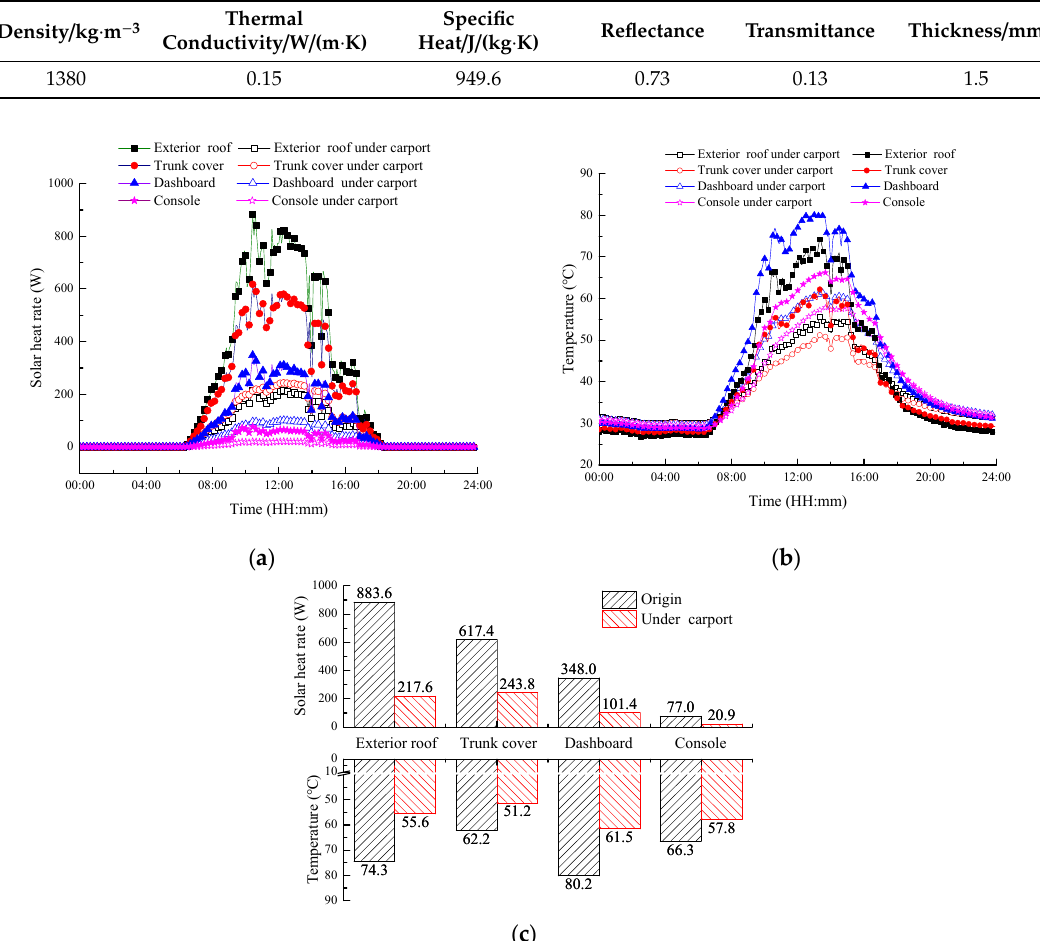
Figure 16. The comparison of automobile weathering external factors on the conditions of carport and outdoor location: ( a ) the all-day solar heat rate on the exterior and interior parts; ( b ) the all-day temperature on the exterior and interior parts; and ( c ) the difference of weathering external factors under the conditions of carport and outdoor.